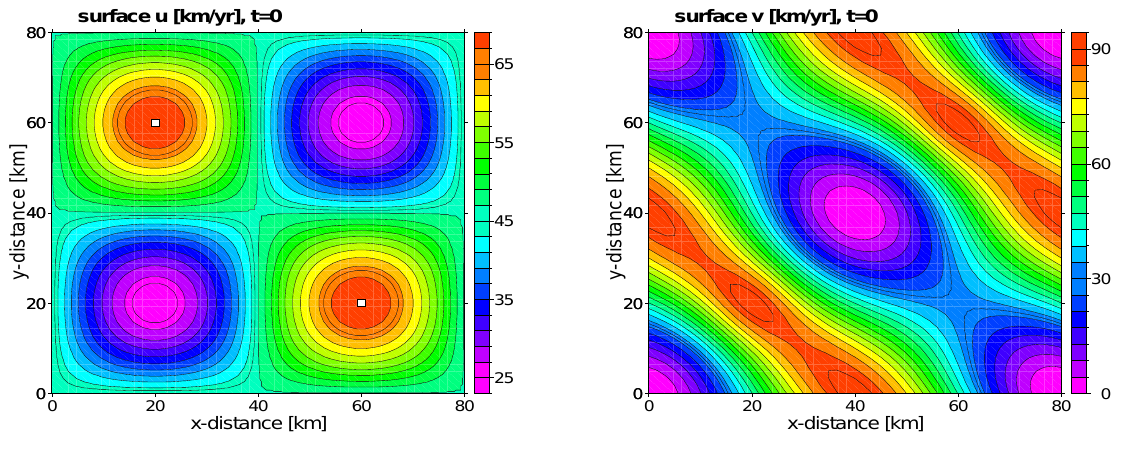
Fig. 6. 3-D time dependent experiment – ice flow over a bumpy bed. The graphs show the bed and ice surface at the beginning (left) and at the steady state (right). All distances are scaled. Ice flow is from left to right. The ice surface changes from a linear sloping surface to the surface draped over the topography of the bed. Ice thickness is spatially uniform when the steady-state solution is reached.